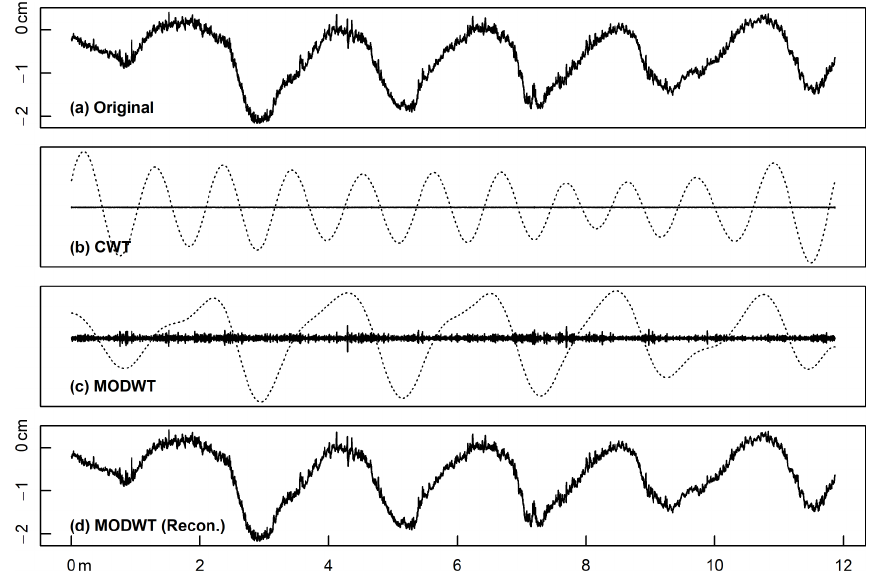
Figure 1. (a) Thalweg elevation profile at end of Experiment 1a (this study) featuring a prominent pool–riffle sequence, where the x axis represents distance upstream, (b) grain ( λ = 4mm) and form ( λ ≈ 2m, dashed line) wavelengths derived from CWT, (c) the same two wavelengths derived from a MODWT, and (d) the original signal reconstructed from the MODWT by recombining wavelengths.